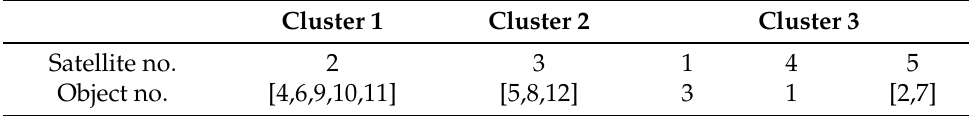
Table 4. Final task-planning results of the example.